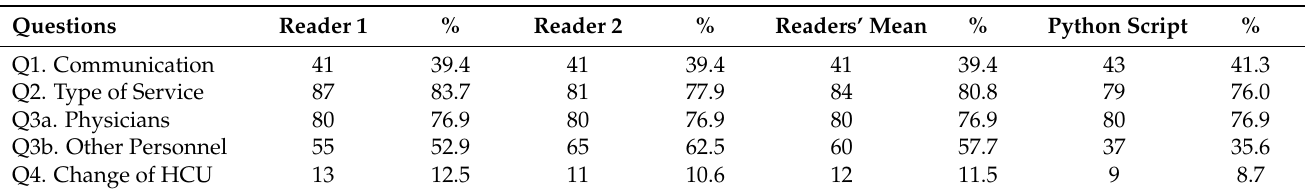
Table 2. Human readers’ and Python script classifications for five questions on patients’ experience for the collection of texts ( n = 104).